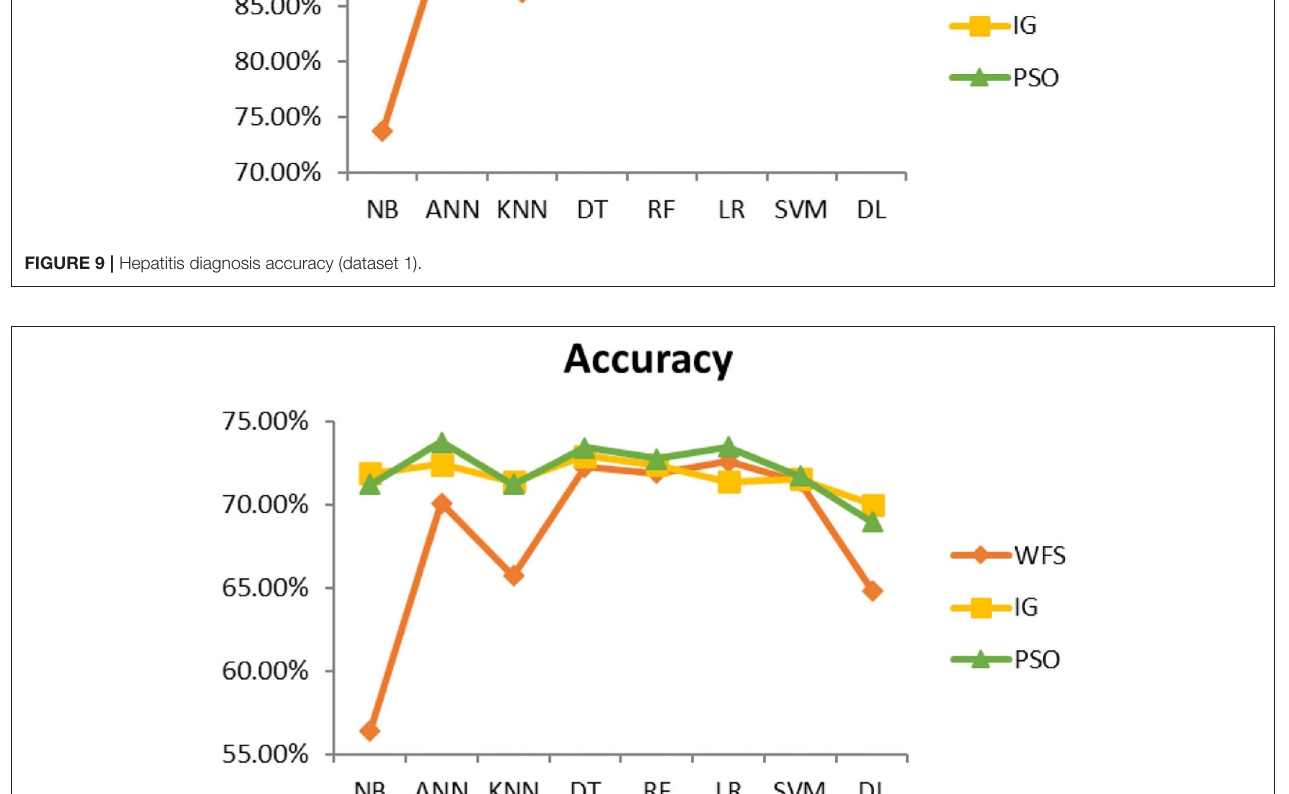
FIGURE 10 | Hepatitis diagnosis accuracy (dataset